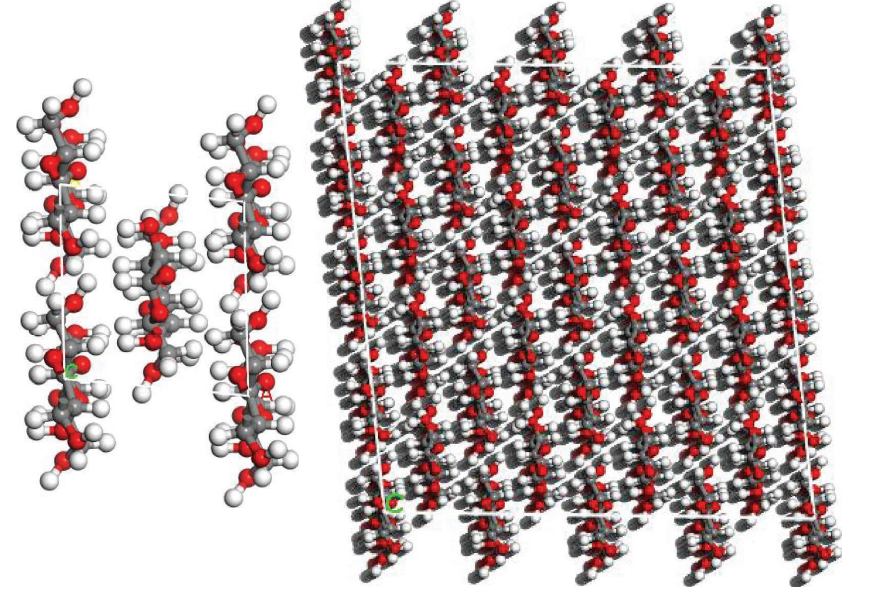
Figure 4: Cellulose I β crystal and its supercell (4 × 4 × 8).